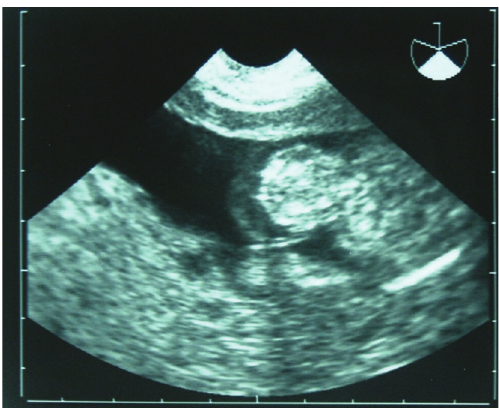
Figure 1: Ultrasound: fetus with omphalocele.